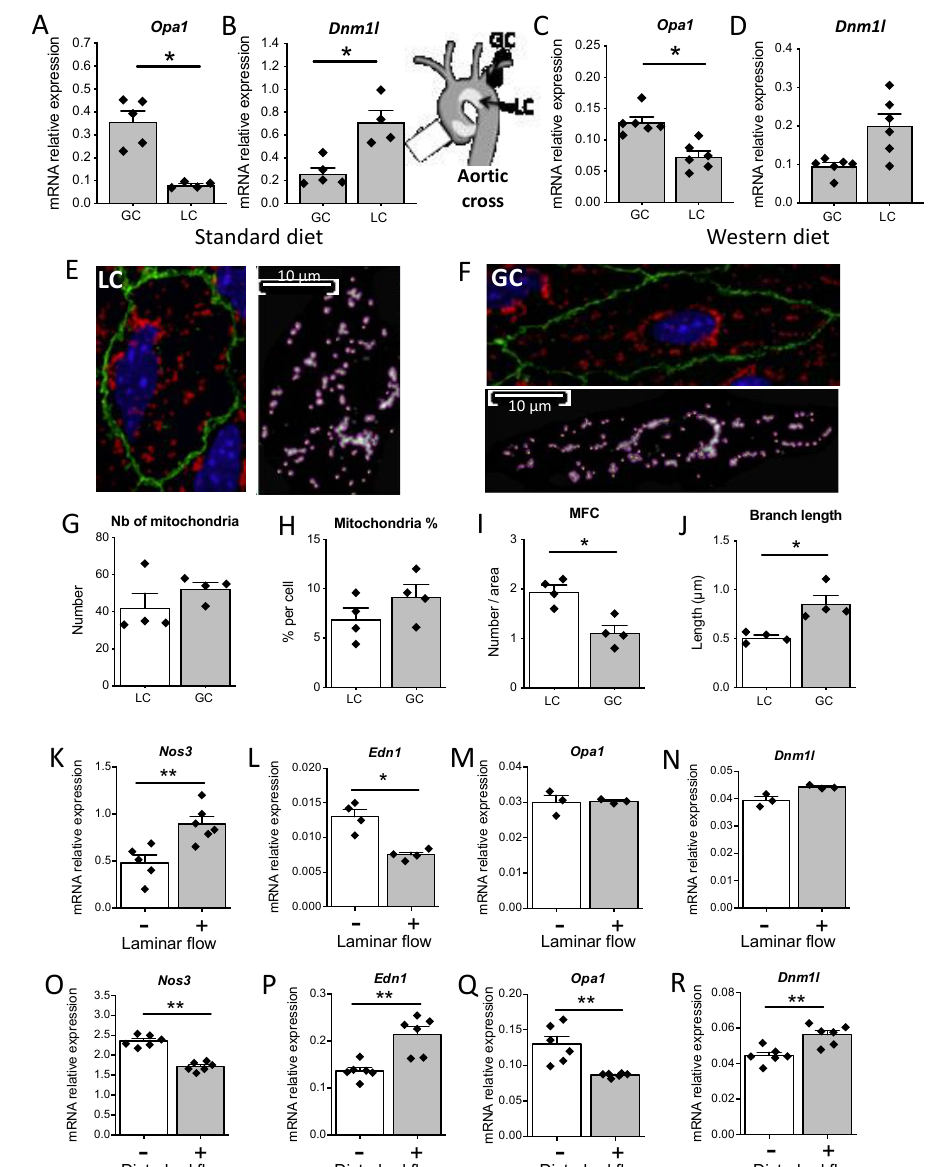
Figure 7. Disturbed flow and mitochondrial dynamics. Drp1 ( Dnm1l ) and Opa1 ( Opa1 ) expression levels were determined in the lesser curvature (LC) and in the greater curvature (GC) of the mouse aortic cross. Mice were fed normal ( A , B ) or Western diet ( C , D ). In a separate series of experiments ( E – J ), mitochondrial shape was analyzed in the LC ( E ) and in the GC ( F ) and the number (Nb) of mitochondria ( G ), the % of mitochondria per cell ( H ), the mitochondria fission count ( I ) and the mean branch length ( J ) were determined. Finally, MS1 cells were submitted to laminar ( K – N ) or disturbed flow ( O – R ) using an orbital shaker and circular flow. After 72 h cells were collected for the measurement of eNOS ( Nos3 ), endothelin-1 ( Edn1 ), Opa1 ( Opa1 ), and Drp1 ( Dnm1l ) expression levels. Means ± SEM are shown ( A – J : n = 4 to 6 mice per group; K – R : n = 3 to 6 independent experiments). * p < 0.05 and ** p < 0.01, two-tailed Mann–Whitney test